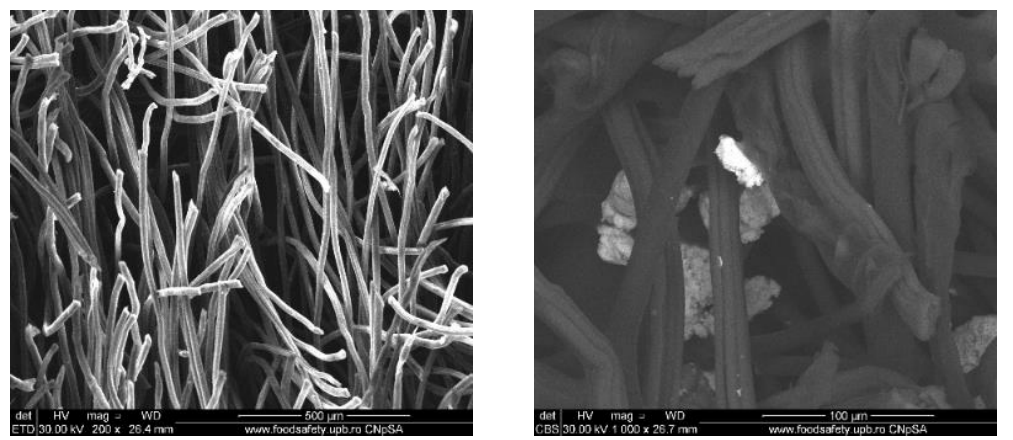
Figure 4. SEM images of wound dressings with silver nanoparticles and sodium alginate. Left: global image, and right: detailed image.